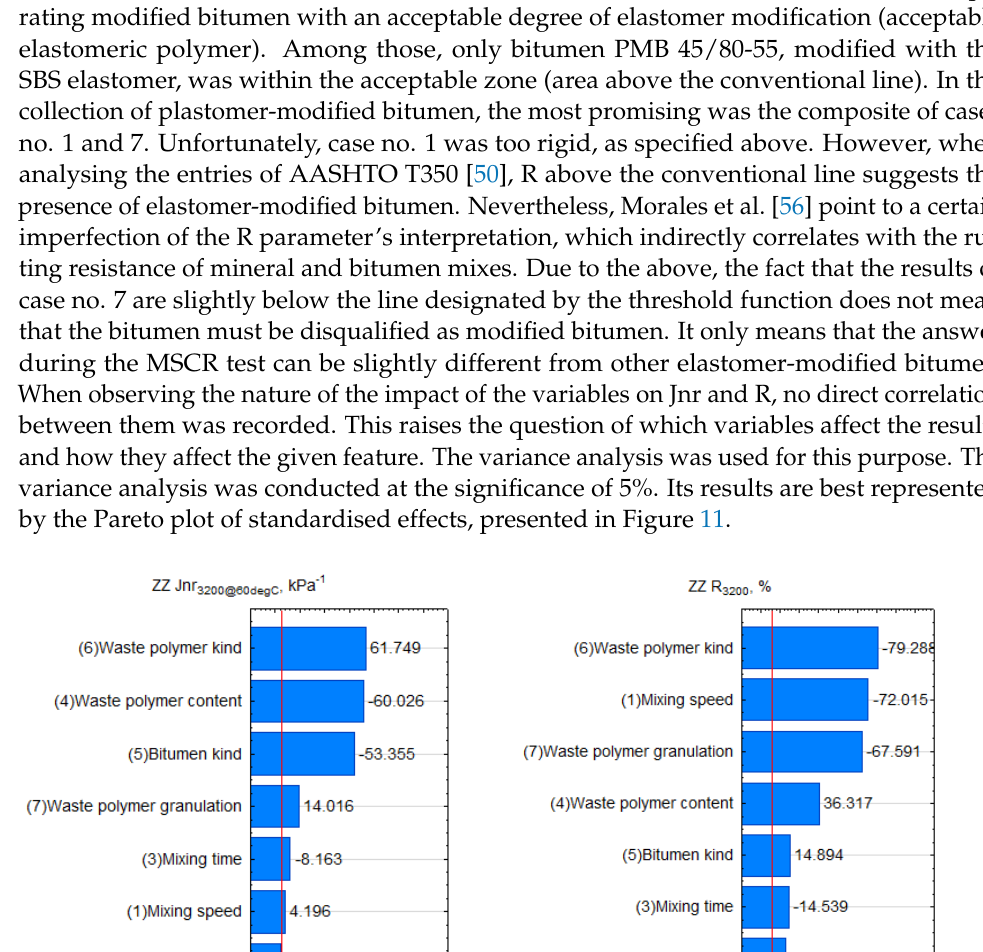
Figure 10. Creep compliance vs recovery.